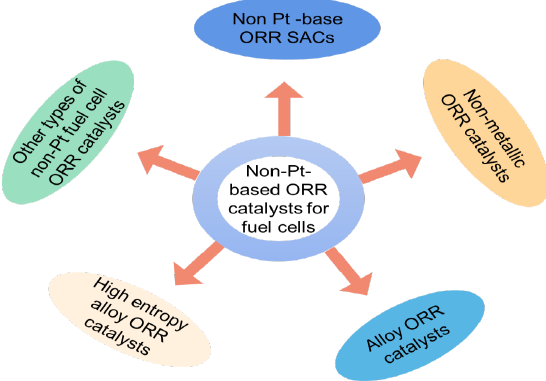
Figure 1. Outline of the major topics covered in this